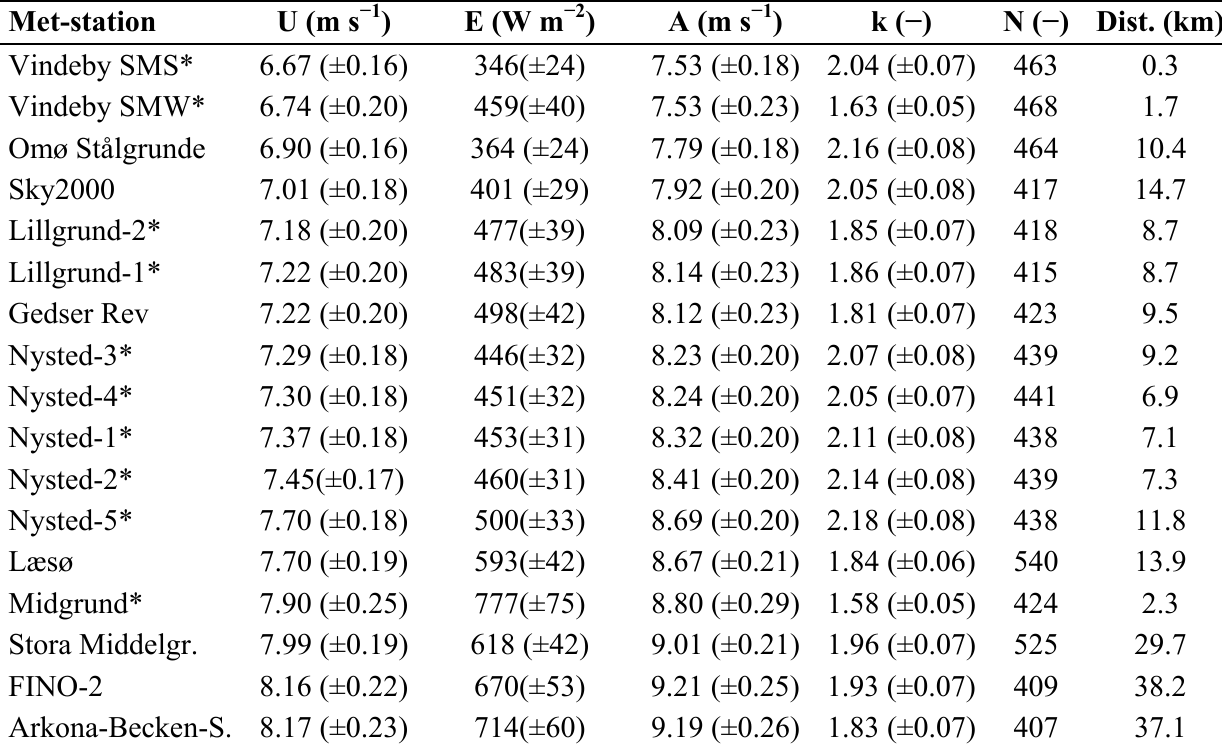
Table 6. SAR-based wind resource statistics listed with increasing mean wind speed (U), and including wind power density (E), Weibull A and k, number of samples (N) and the distance to the nearest coast. The satellite wind maps are from Envisat ASAR from March 2003 to April 2010. Sampling uncertainties are shown in brackets. *nearby wind